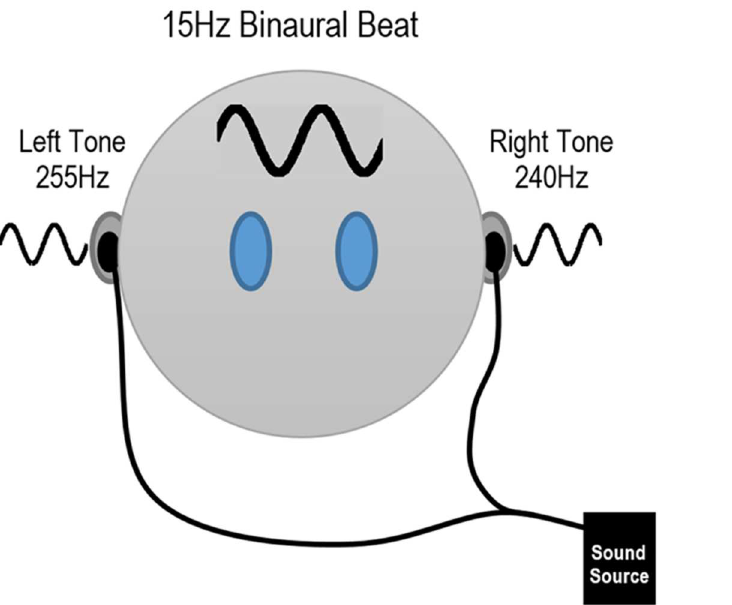
Fig 1. Example of a 15Hz Binaural